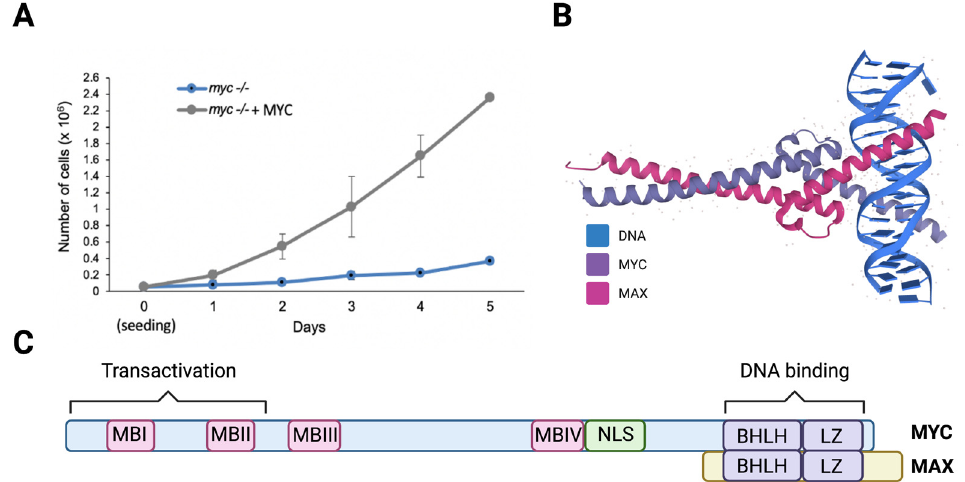
Figure 3. MYC heterodimerizes with MAX and increases cell proliferation. ( A ) Proliferation curve of HO15.19 myc -/- rat fibroblasts expressing empty vector or MYC. Cells were seeded and counted for 5 days. ( B ) The structure of the basic helix-loop-helix and leucine zipper (bHLH-LZ) domains of the heterodimer MYC-MAX and DNA (PDBe-KD), https://www.ebi.ac.uk/pdbe/pdbe-kb/proteins/P01106/interactions, (accessed on 28 November 2021). ( C ) Schematic representation of the MYC protein sequence with MYC Boxes (MBI, MBII, MBIII, MBIV), nuclear localization signal (NLS), and bHLHLZip domain on the C-terminus where DNA and MAX interacts. Figure created using Biorender.com (accessed on 28 January 2022).